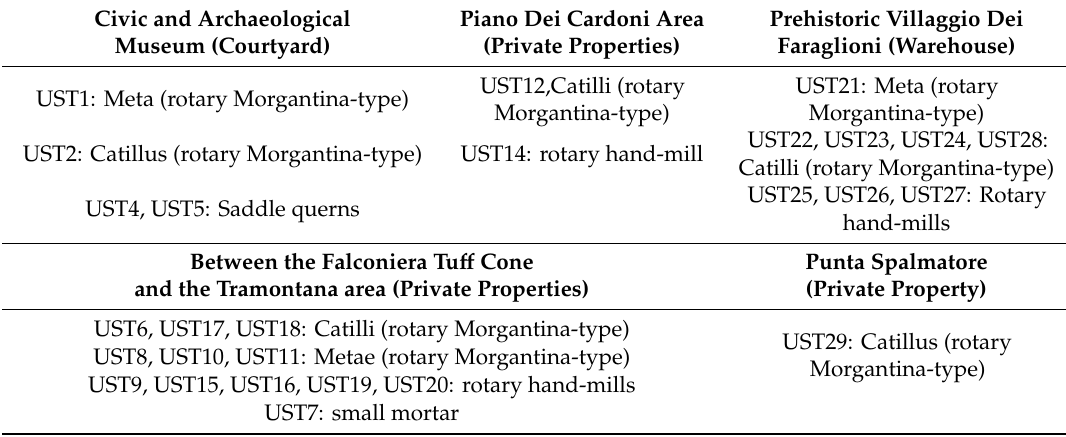
Table 1. Summary of the investigated grinding stones, showing the di ff erent milling techniques (millstone type) and their locality of sampling in Ustica